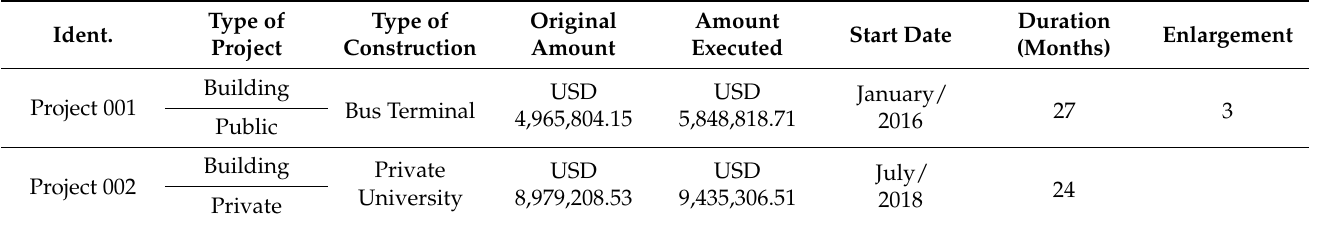
Table 4. General description of projects (source: Proaño-Narv á